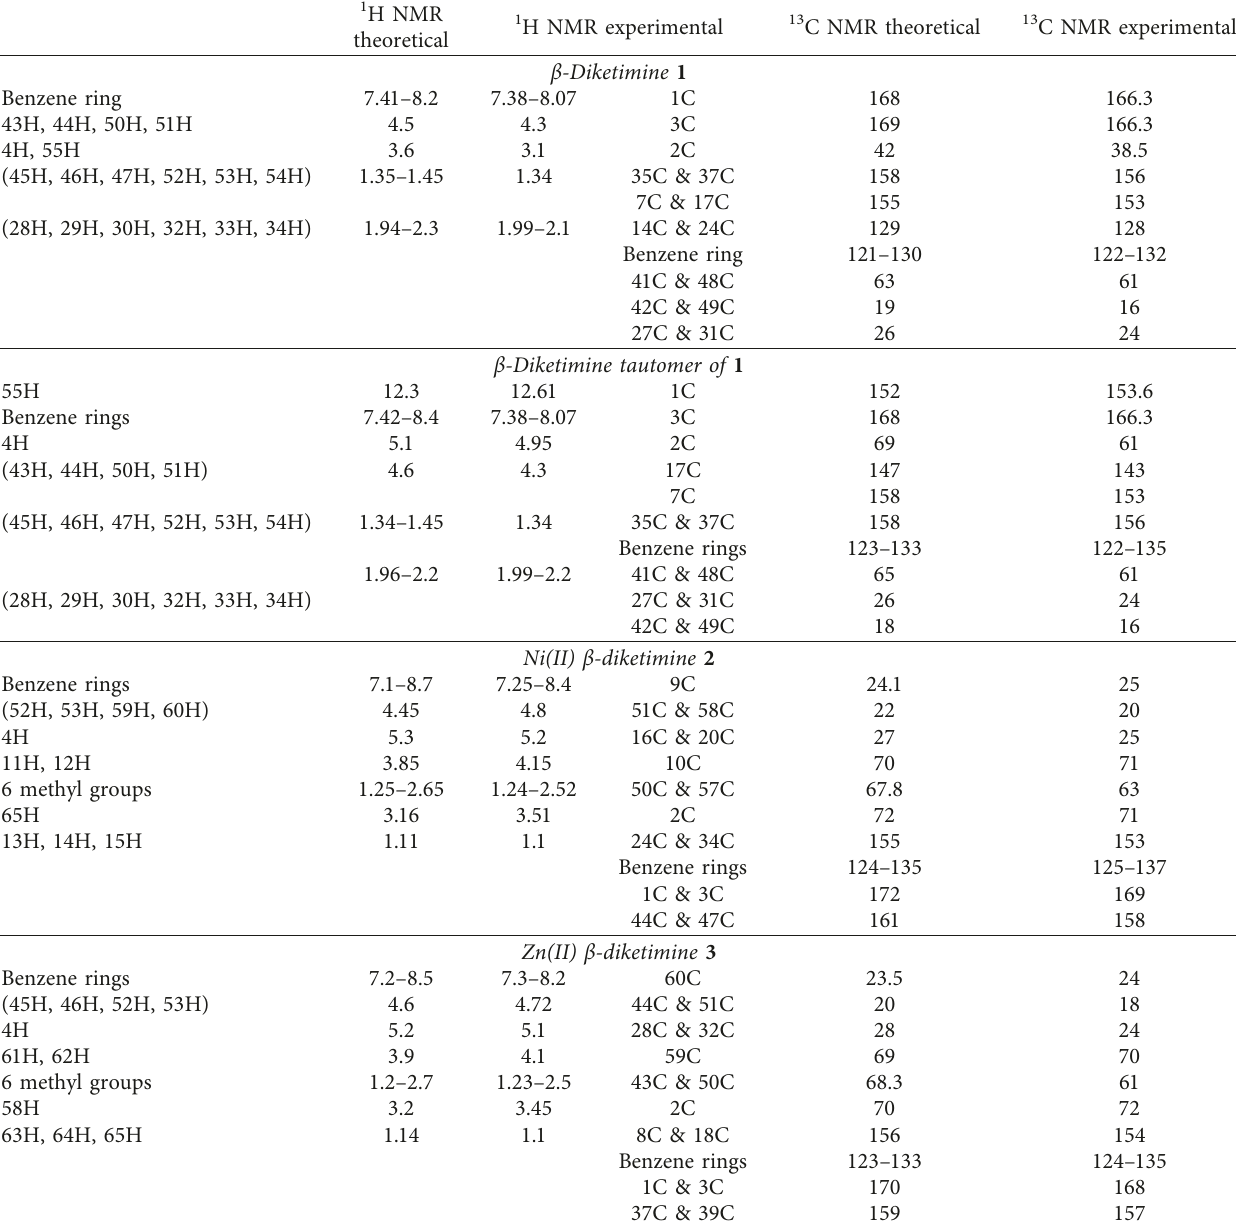
Scheme 3: Preparation of complexes of metal ions Ni(II) and Zn(II) Table 1: 1 H and 13 C NMR theoretical and experimental values for the structures of 1 & 2 (in ppm).